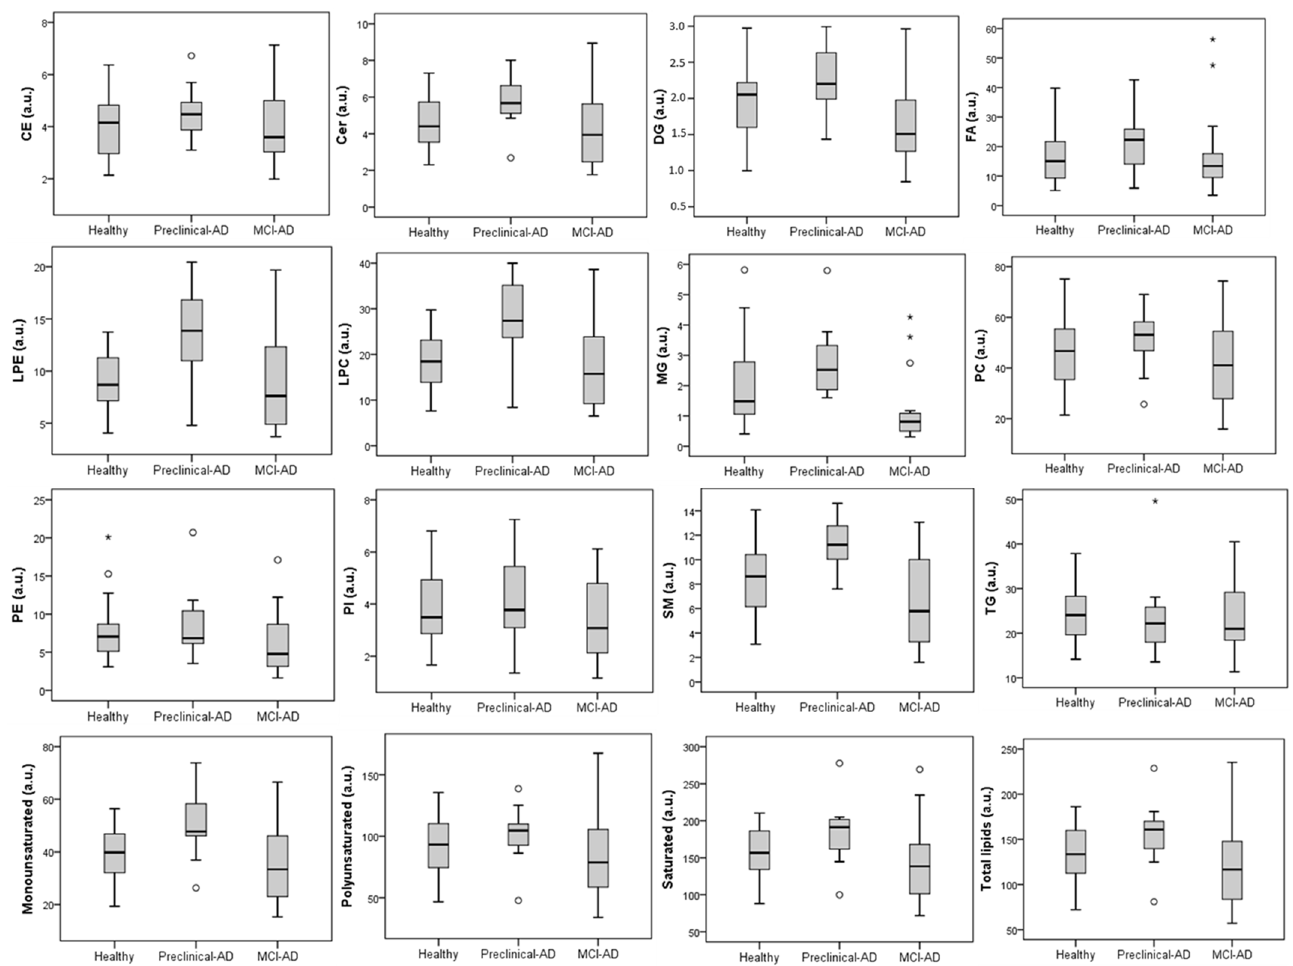
Figure 2. Lipid families identified from untargeted lipidomic analysis and identification by LipidMS package. CE: Cholesterol esters; Cer: Ceramides; DG: Diglycerols; FA: Fatty acids; LPC: Lys phos- phatidylcholines; LPE: Lysophosphatidylethanolamines; MG: Monoglycerides; PC: Phosphatidyl- cholines; PE: Phosphatidylethanolamines; PI: Phosphatidylinositols; SM: Sphingomyelins; TG: Tri- glycerides.